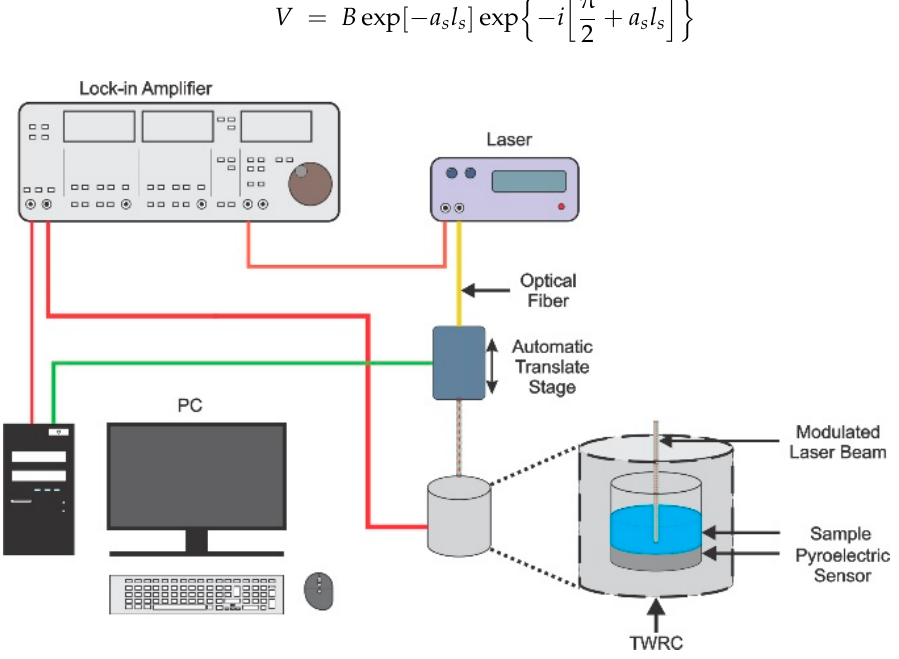
Figure 2. Scheme of the experimental setup of the TWRC.